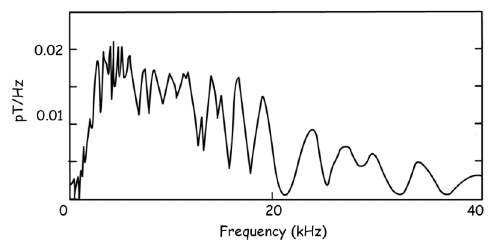
Fig. 4. Typical sferics frequency spectrum.